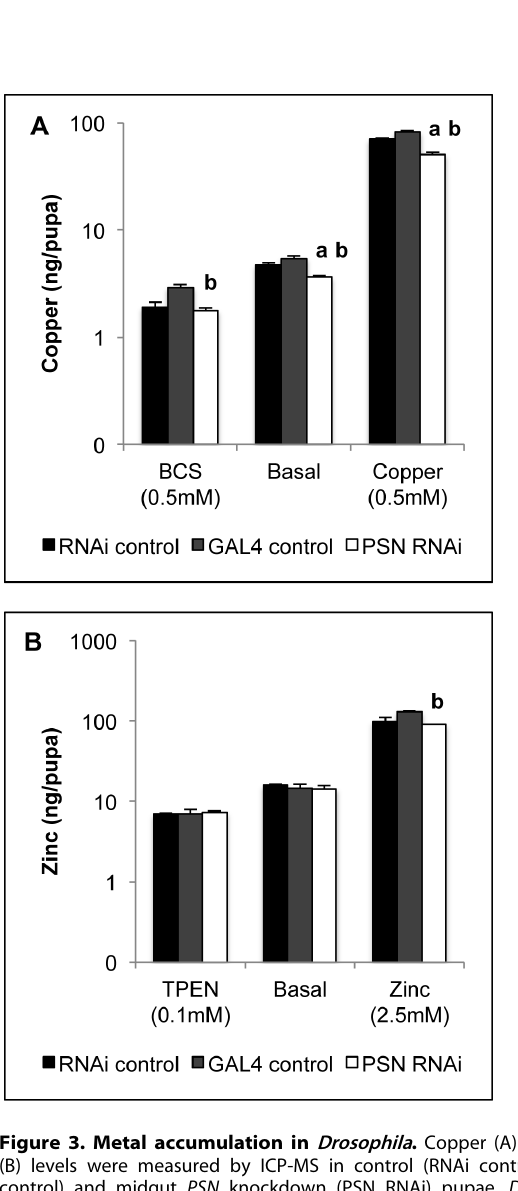
Figure 3. Metal accumulation in Drosophila . Copper (A) and zinc (B) levels were measured by ICP-MS in control (RNAi control, GAL4 control) and midgut PSN knockdown (PSN RNAi) pupae. Drosophila were reared on either copper chelator (0.5 mM BCS), basal media or 0.5 mM copper (A) or zinc chelator (0.1 mM TPEN), basal media or 2.5 mM zinc (B). Values are mean metal content per pupa with S.E.M.